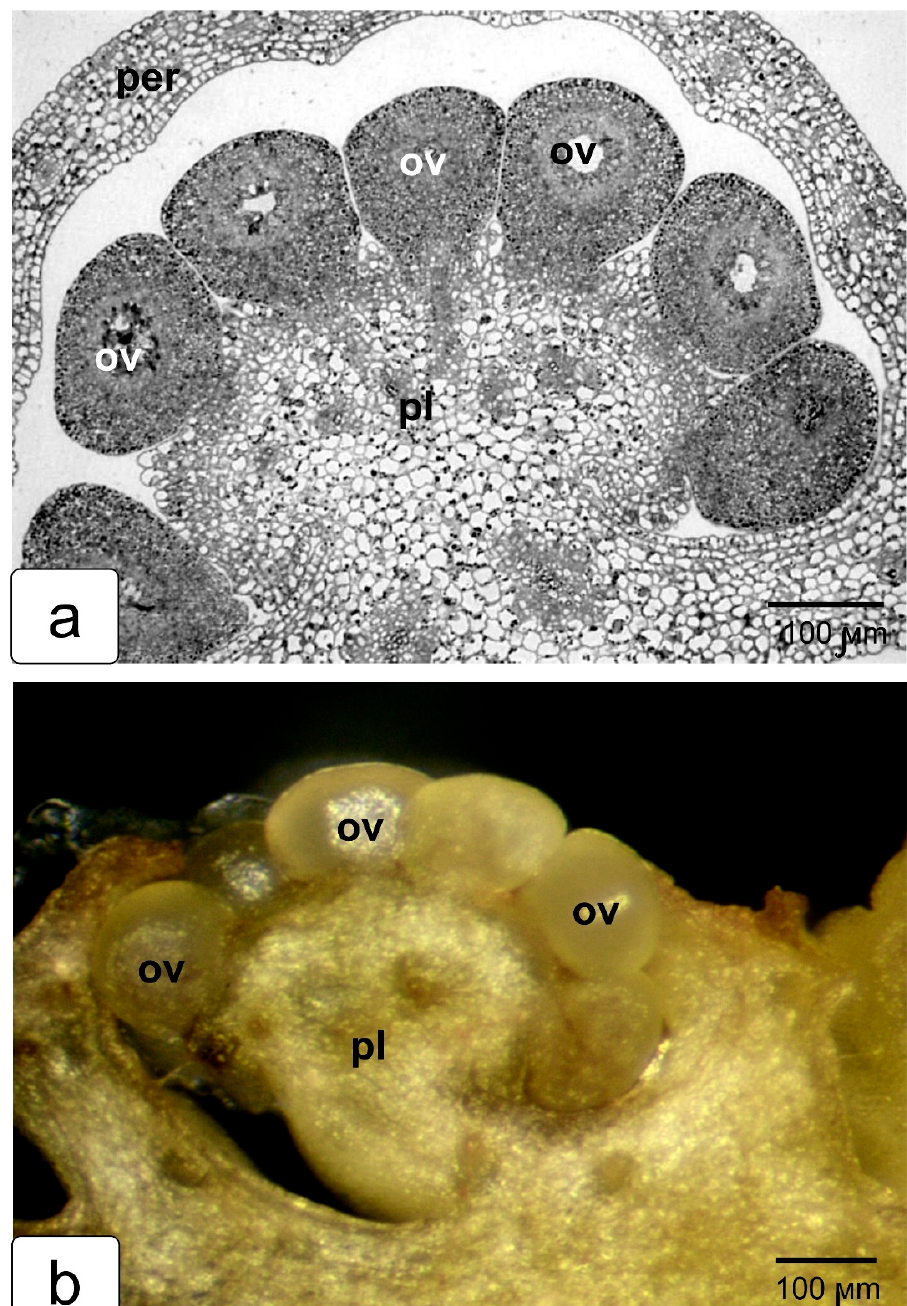
Figure 3. Locular cavity (seed chamber) of a tomato fruit at an early (initial) stage of development: transverse anatomical section ( a ); locular cavity of a fruit of about the same age after manual dis- section ( b ). Designations: ov—ovule; per—pericarp; pl—placenta. dissection ( b ). Designations: ov—ovule; per—pericarp;